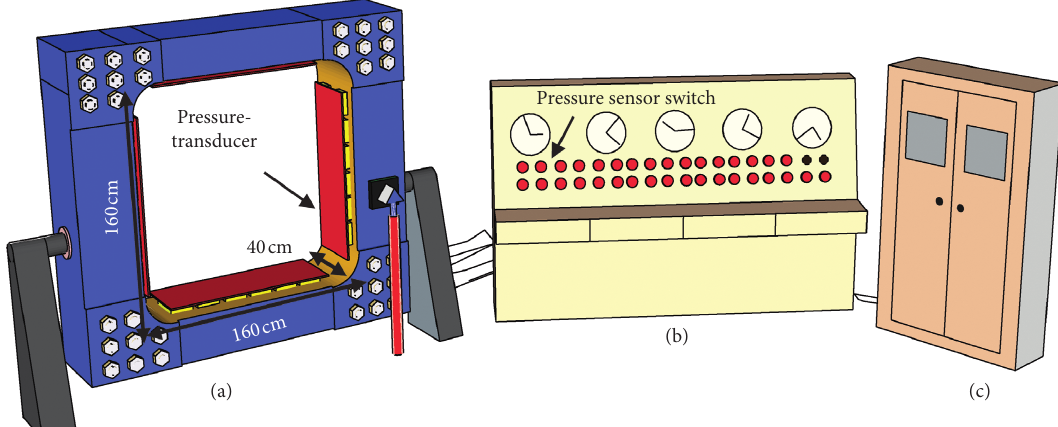
Figure 4: Schematic diagram of the main engine and hydraulic control system. (a) Main engine. (b) Work station. (c) Nitrogen gas